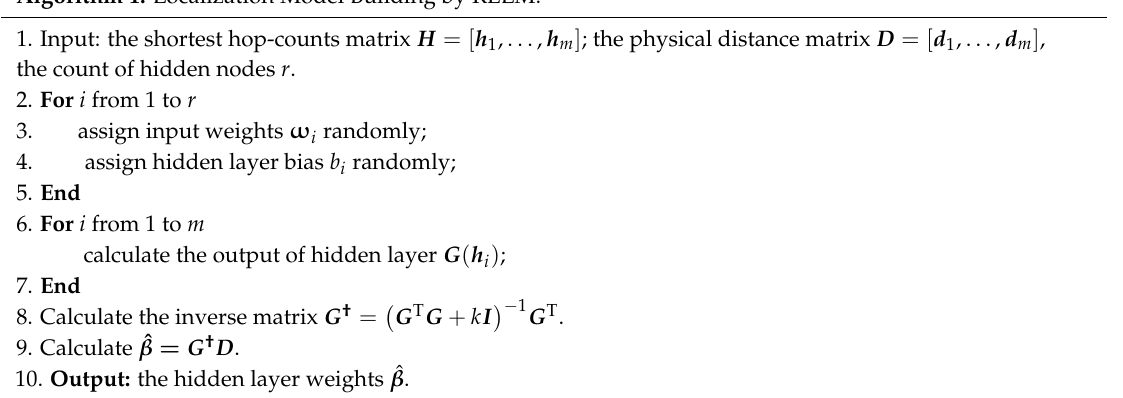
Algorithm 1. Localization Model Building by